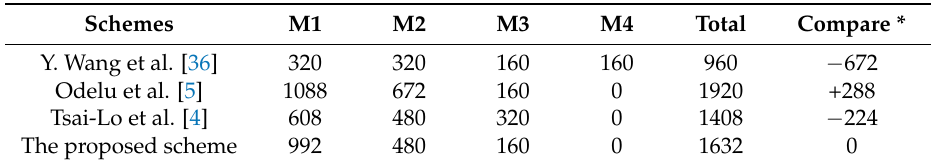
Table 17. Communication